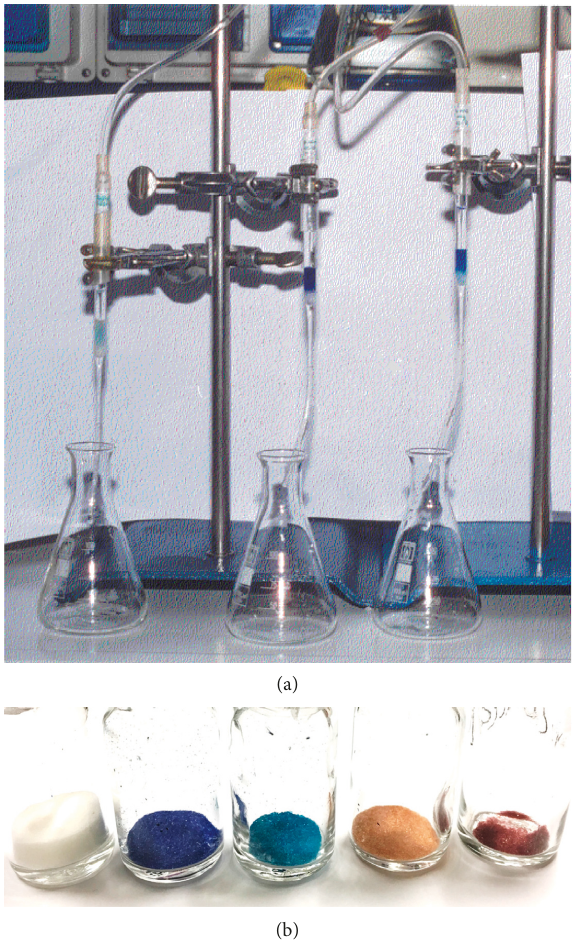
Figure 1: Assembled columns for ion adsorption/desorption ex- periments (a) and coloured dry hybrid materials isolated after Cu 2+ and Co 2+ chelation